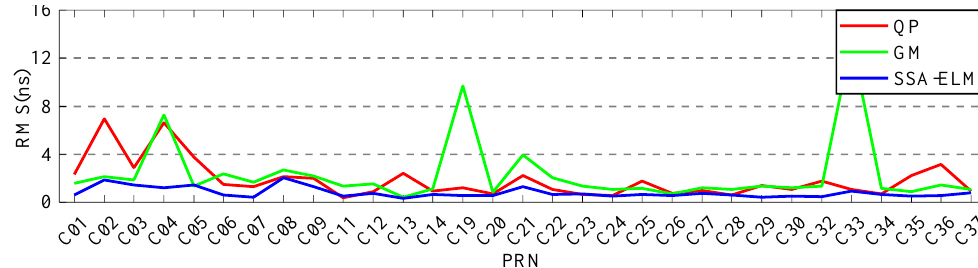
Figure 17. The prediction accuracies of BDS for 6 h obtained using 6 h of SCB data.